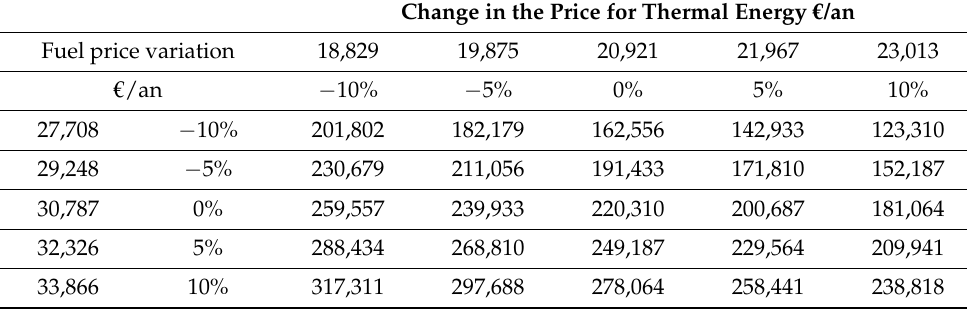
Table 7. Sensitivity analysis of Scenario